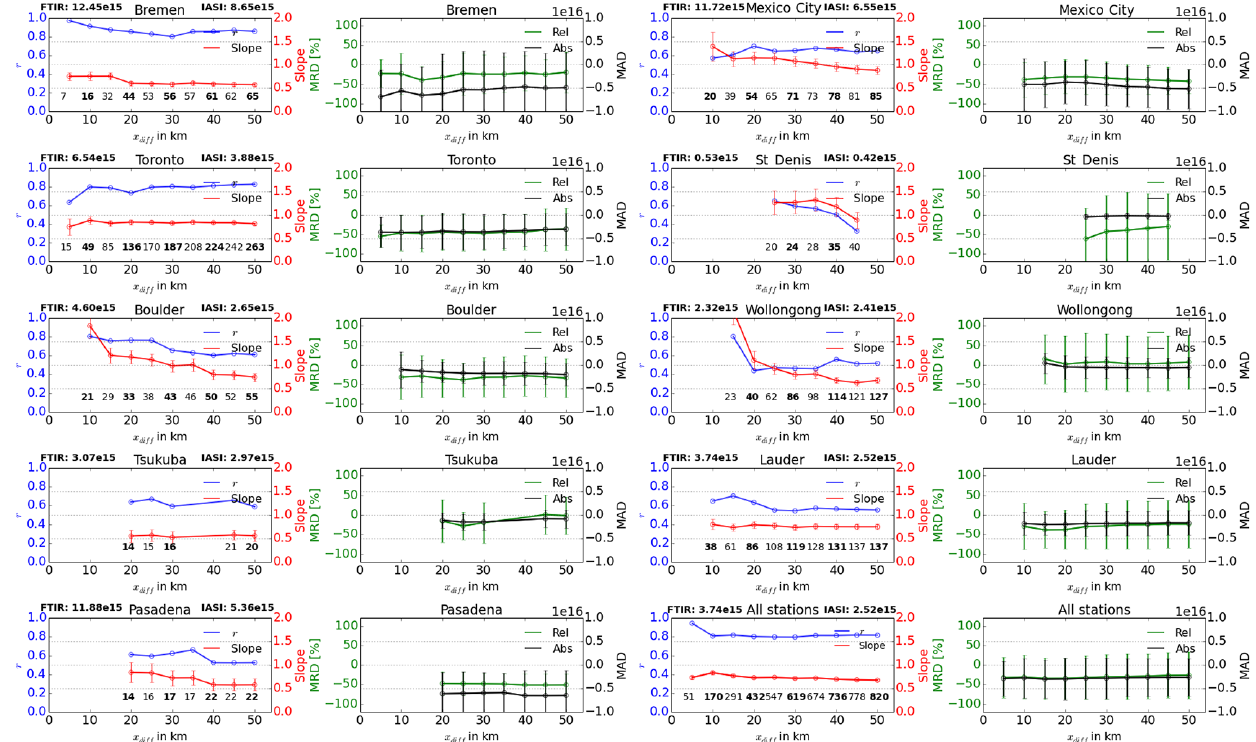
Figure A1. Correlation r (blue lines, left figures), slope (red lines, left figures) regression results, mean relative difference (MRD, green lines, right figures) and mean absolute difference (MAD, black lines, right figures) between IASI and FTIR observations as a function of x diff for all sites. Bars indicate the standard deviation of the slope of the individual regression results. The numbers in the bottom of each subfigure show the number of matching observations. The numbers on the left and right side of the station name give the mean FTIR and IASI total columns for an x diff <